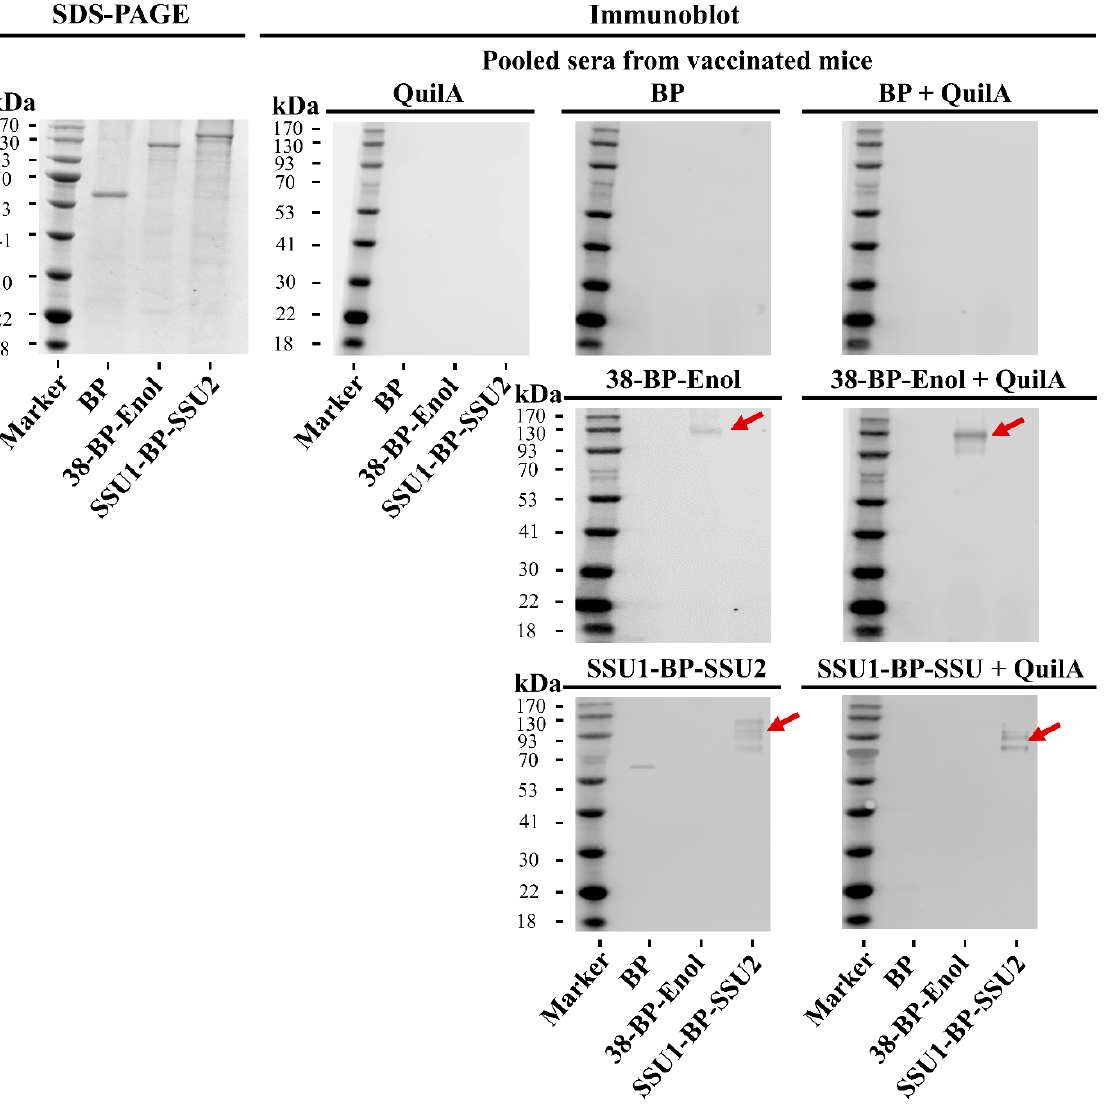
Figure 4. BP vaccines induce specific immune responses to the incorporated antigens. Specific antigen recognition was analyzed by immunoblotting using pooled sera from mice ( n = 10 per group) vaccinated with BPs. The 38-BP-Enol and SSU1-BP-SSU2 are shown in red arrows.